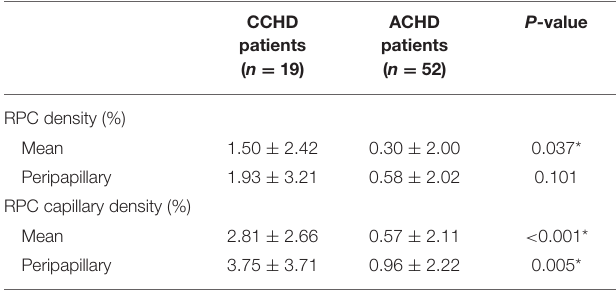
TABLE 6 | Comparison of changes in retinal vessel density between CCHD and ACHD patients.